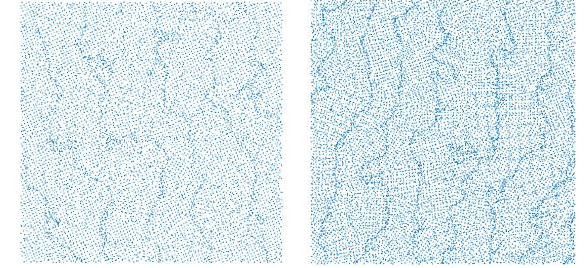
Figure 11. Point patterns for test area n. 1 and for scenarios 1 (left) and 4 (right) Things are different when the sloped area n. 3 is considered.